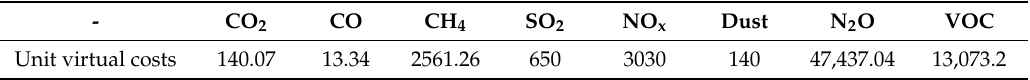
Table 4. Unit virtual abatement costs of air pollution (unit: CNY / t).